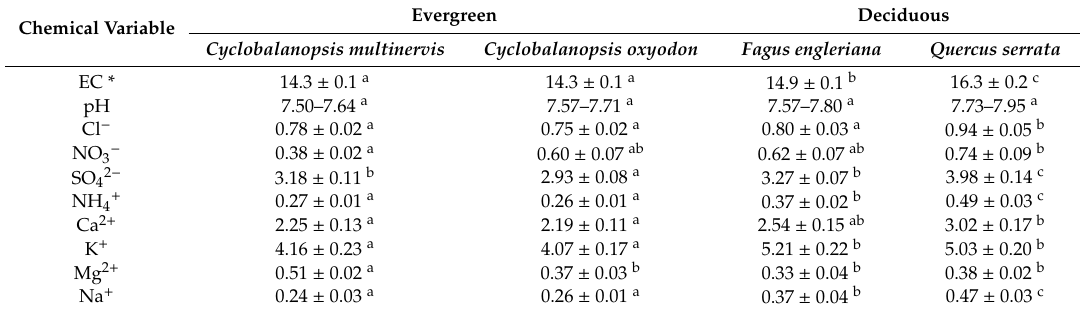
Table 2. Chemical characteristic of water in stemflow of the four tree